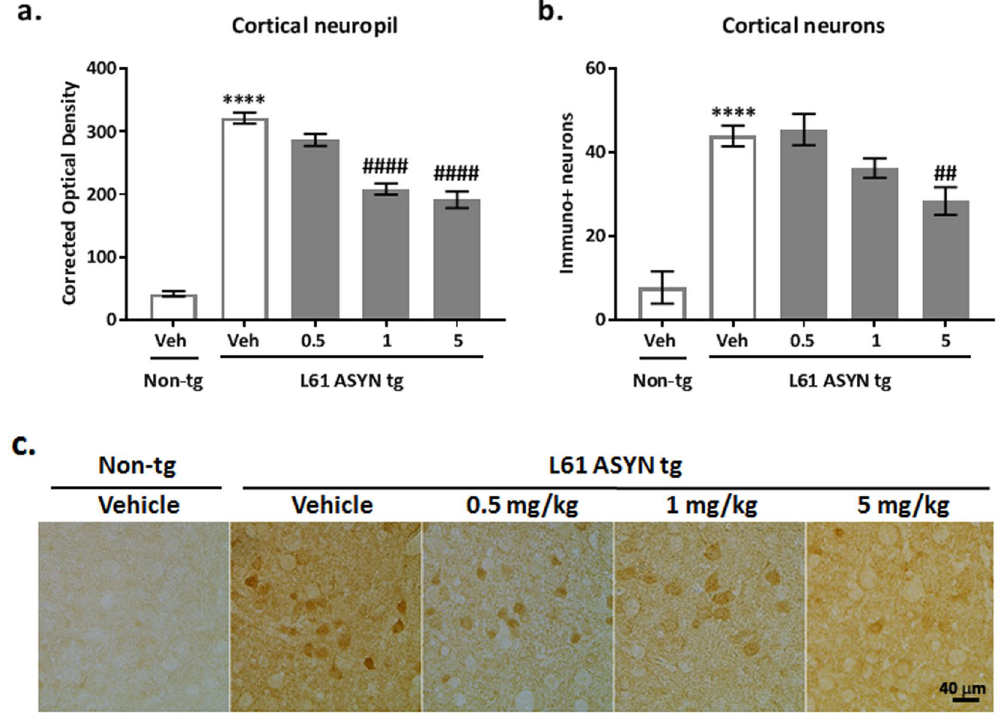
Figure 6. NPT200-11 administration decreased ASYN immunolabeling of cortical neuropil and neurons in the Line 61 ASYN transgenic mouse. There was a statistically significant increase in ( a ) ASYN immunolabeling in the cortical neuropil and ( b ) number of ASYN immunolabeled neuronal cell bodies of Line 61 ASYN transgenic mice ( **** p < 0.0001 vs. non-transgenic/vehicle controls ). NPT200-11 administration (1 & 5 mg/kg) produced statistically significant reductions in transgenic ASYN levels in the (a) cortical neuropil ( #### p < 0.0001 vs. Line 61 ASYN transgenic/vehicle controls ), and a trend (p = 0.0523) for reduction in cortical neuropil of Line 61 transgenic ASYN levels in mice treated with 0.5 mg/kg NPT200-11. NPT200-11 administration (5 mg/ kg) produced a statistically significant reduction in (b) the number of ASYN immunopositive neuronal cell bodies in the cortex of Line 61 ASYN transgenic mice ( ## p < 0.01 vs. Line 61 ASYN transgenic/vehicle controls ). Representative images obtained at 40x are shown in (c), where the scale bar represents 40